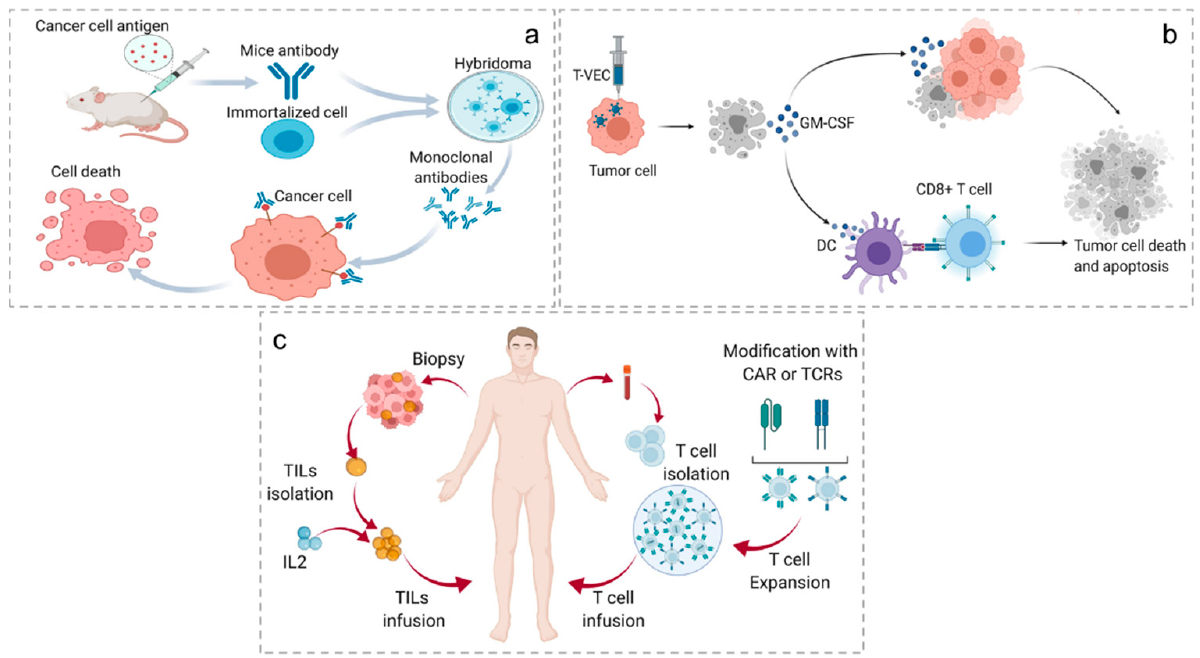
Figure 3. Mechanisms of passive immunotherapy. ( a ) Immunization of mice with cancer-specific antigens to stimulate antibody production, antibody–cell fusion, hybridoma selection and amplification. Then, monoclonal antibody binds to cancer cells. Finally, effector immune cells recognize antibodies bound to cancer cells, leading to cell death. ( b ) After the patient was injected with engineered T-VECs, apoptotic tumor cells released GM-CSF. The specific effects are as follows: local effect (the released GM-CSF causes the apoptosis of surrounding tumor cells) and systemic effect (GM-CSF activates DCs, activating CD8 + T cells). Finally, tumor cell death and apoptosis occur. ( c ) CTLs are collected from solid tumors and expanded ex vivo with the systemic administration of IL-2. T cells are acquired from the blood of patients, and then CAR/TCR T-cell chimeric antigen receptors are created. After extensive amplification, they are reinjected into the patient.